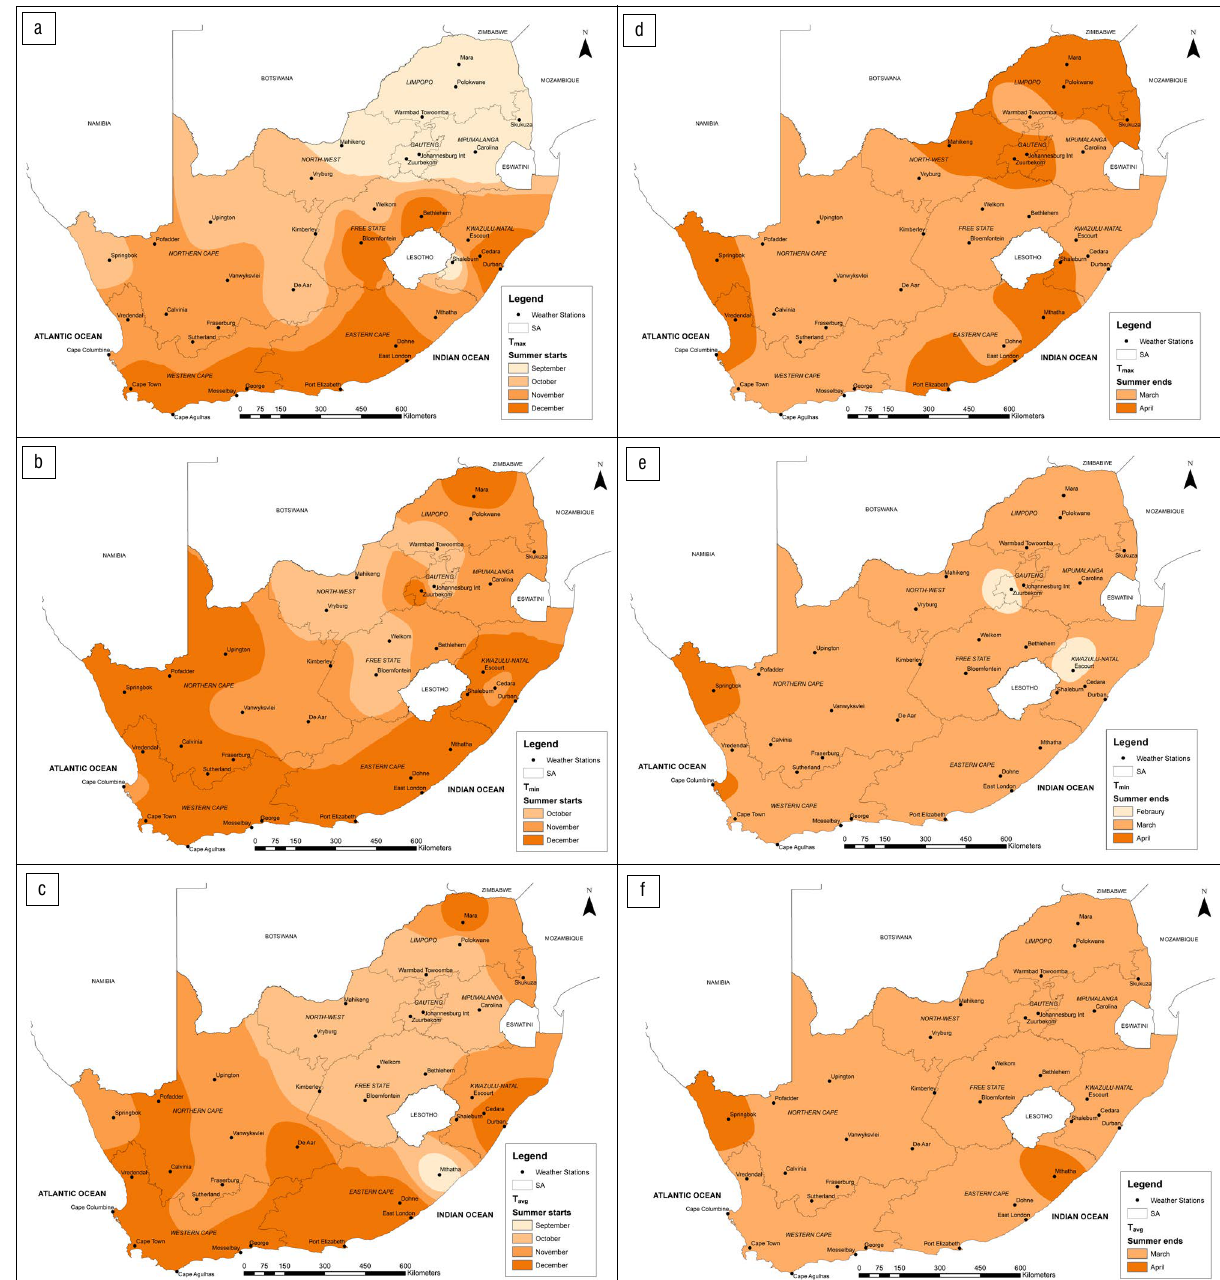
Figure 3: (a–c) Start of summer and (d–f) end of